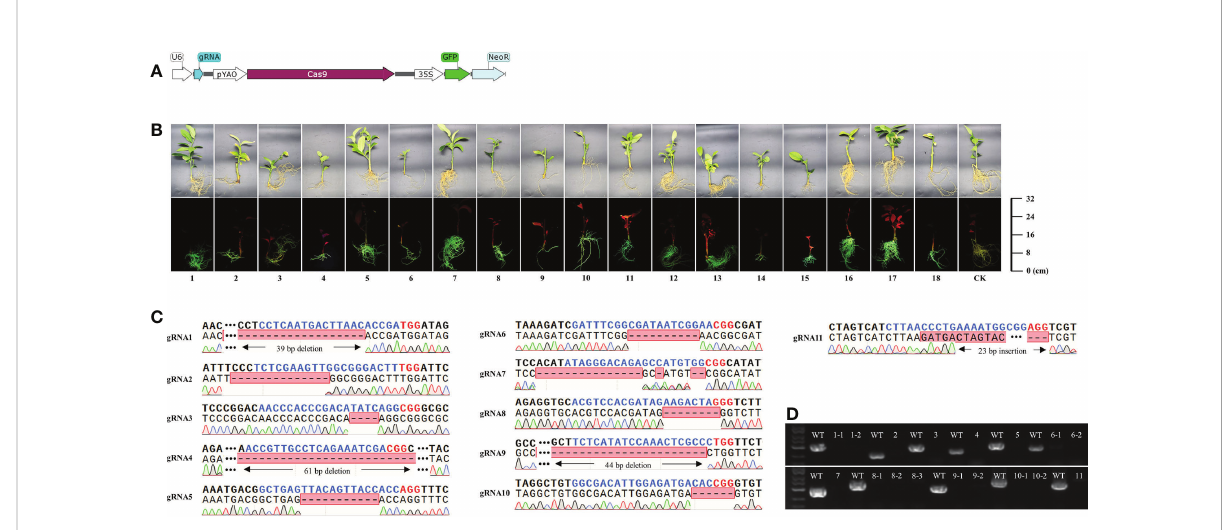
FIGURE 3 Agrobacterium rhizogenes K599-mediated genetic transformation and genome editing is highly ef fi cient. (A) Schematic diagrams of genome- editing elements used in the study. (B) Green fl uorescence signal visualized by laser scanning confocal microscopy in transgenic tissues of citrus roots. (C) Alignment of the genome-edited sequence of corresponding transgenic hairy roots with the gRNA-targeted loci. Blue nucleotides indicate gRNA and red nucleotides indicate PAM. (D) PCR assays conducted at gRNA-targeted sites of transgenic and wild-type